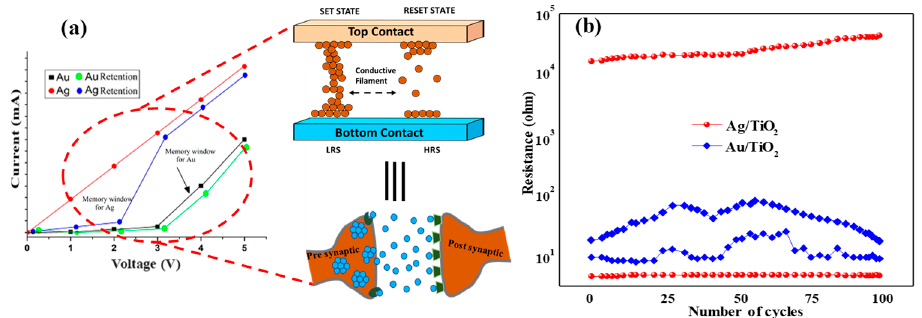
Figure 5. ( a ) Comparison of the I–V curve for both memristors with relation to the memory cross-bar and synaptic concept ( b ) Endurance cycle of the devices.